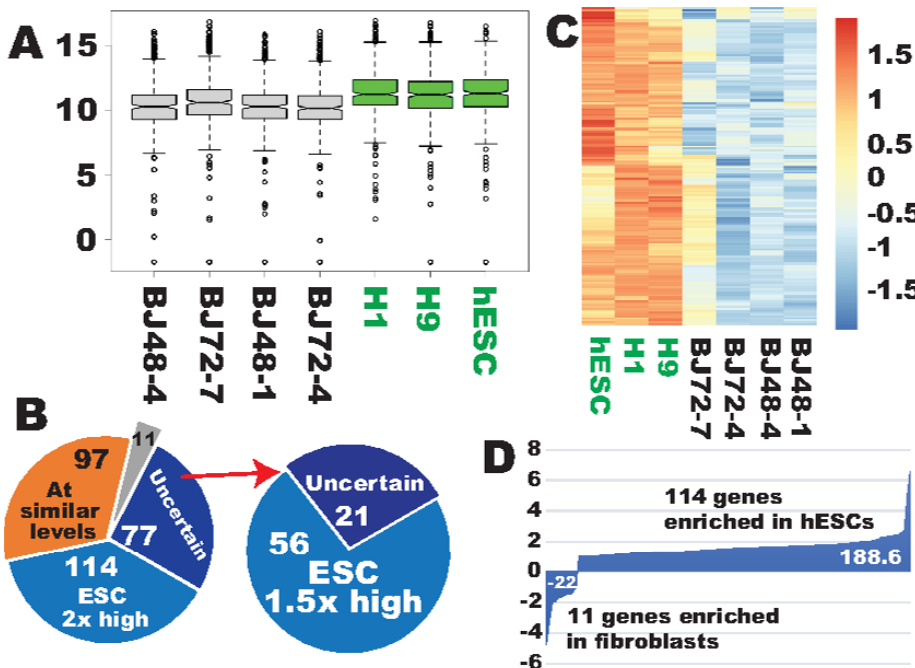
Figure 1. Ribosome biogenesis (GO#, 0042254) was more robust in human embryonic stem cells (ESCs) than in the reprogramming starting cells, fibroblasts. ( A ) Box plots showing that the full set of ribosome biogenesis (RB) genes was expressed at higher levels in human ESCs than in fibroblasts. ( B ) Pie charts showing the expression categories of the RB gene set in human ESCs (hESCs) and fibroblasts. The grey sector in the left pie chart indicates that 11 genes were enriched at least twofold in fibroblasts in comparison with human ESCs (q < 0.01). The right pie chart is a further classification of the uncertain sector in the left pie using less stringent criteria ( > 1.5 × , q < 0.05). ( C ) A heat map showing that 170 out of 291 RB genes were enriched in human ESCs by at least 1.5-fold (q < 0.05). ( D ) Quantification of expression di ff erences for the RB gene set between hESCs and fibroblasts. H1 and H9, human embryonic stem cell (hESC) lines H1 and H9, respectively; hESC is a subline of H1. The first number after the fibroblast designation is the time of RNA harvesting after seeding of cells, and the second number is the lane number of RNA-seq flow cells. The boxes and labels of hESCs are highlighted in green. hESC =